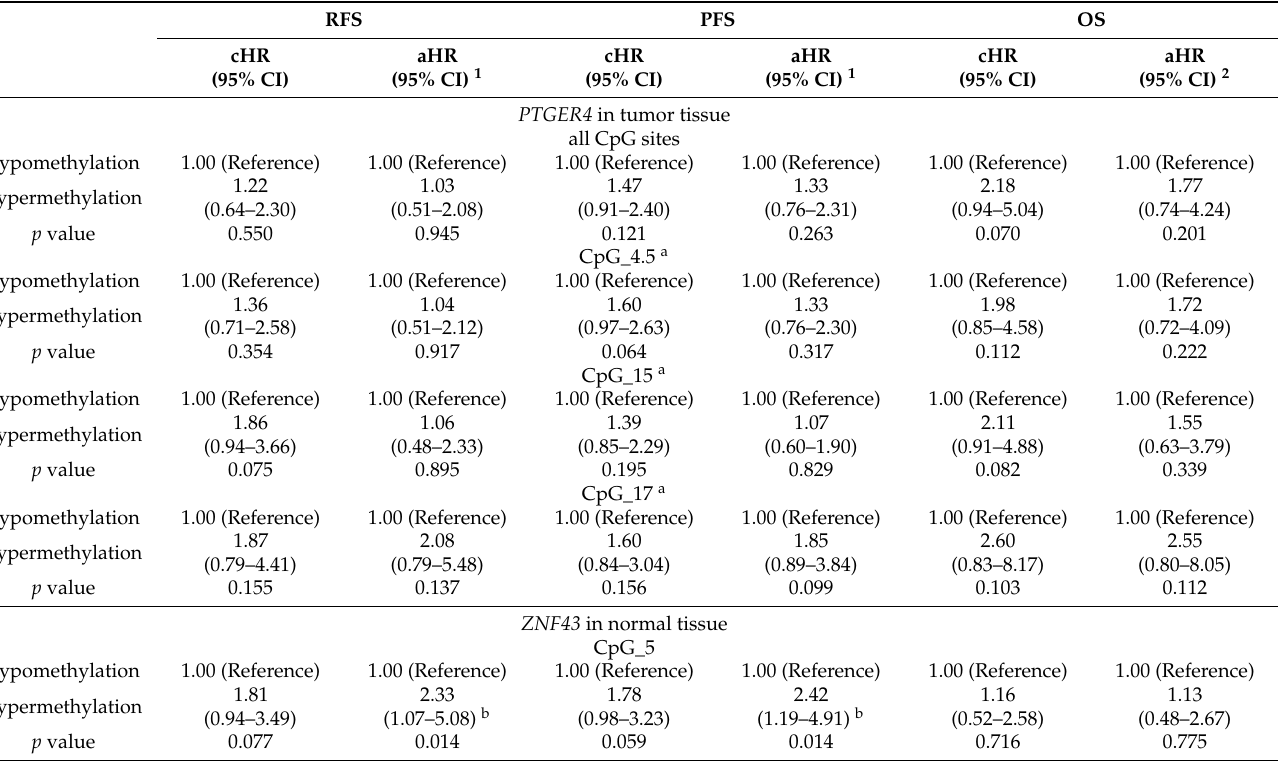
Table 4. Cox regression analysis of methylation in certain CpG loci of PTGER4 and ZNF43 gene and 5-year clinical course.